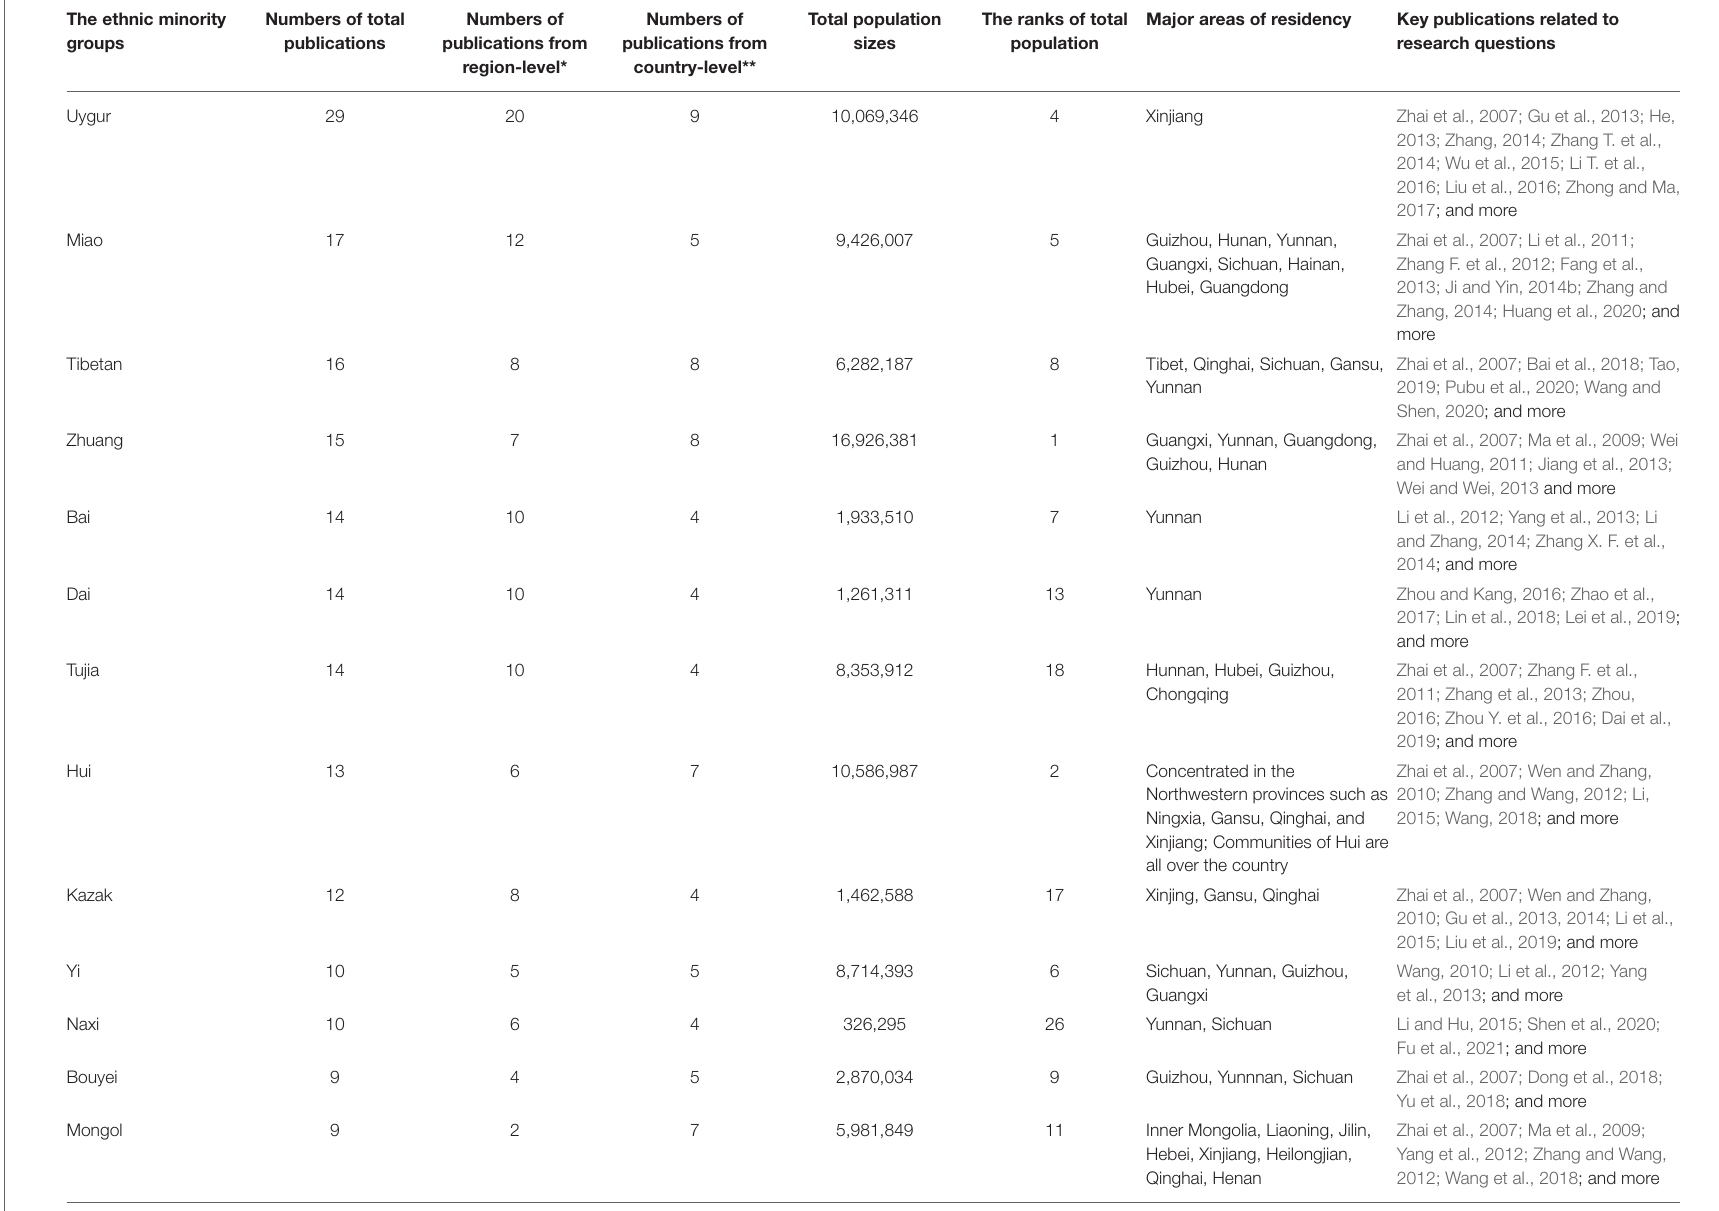
TABLE 2 | Information about numbers of publications, total populations, and major areas of distribution for each ethnic minority